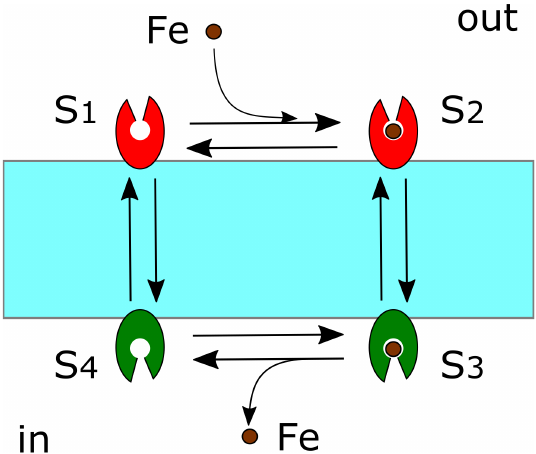
Figure 5. Four-state model. S1: The initial state opens outward; S2: the second state opens outward; S3: the third state turns inward; S4: the fourth state opens inward. In this figure, the four states are all